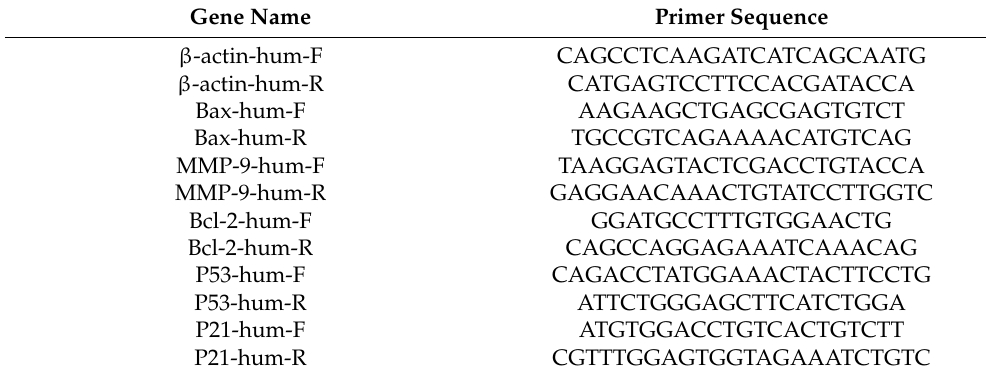
Table 1. Characteristics of primers used in qPCR